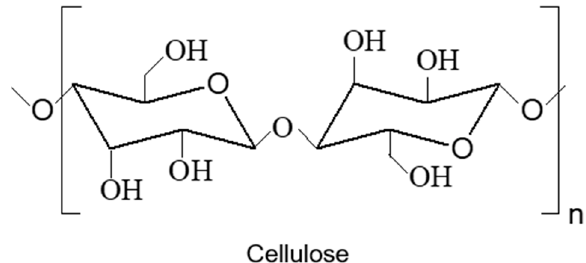
Figure 6. Chemical structure of cellulose.